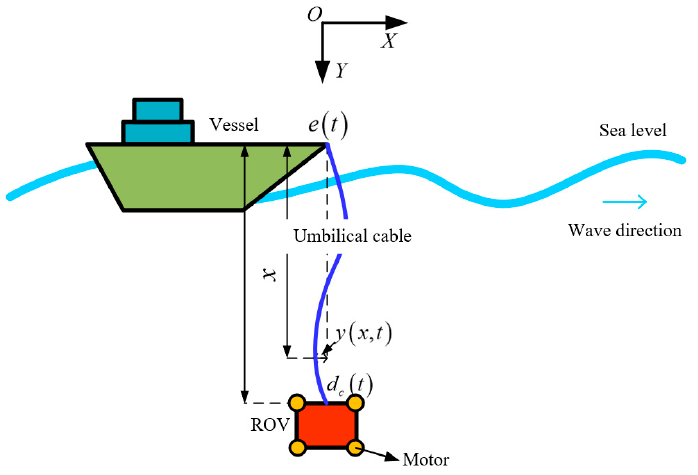
Figure 1. Motor-driven deep-sea robot cable system (MDRCS).